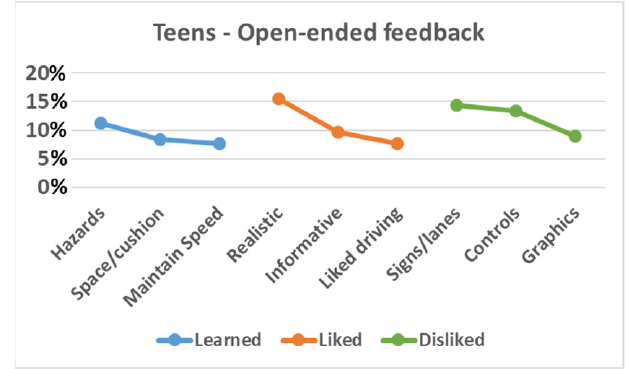
Figure 18. Teen Assessment Open-ended Summary.